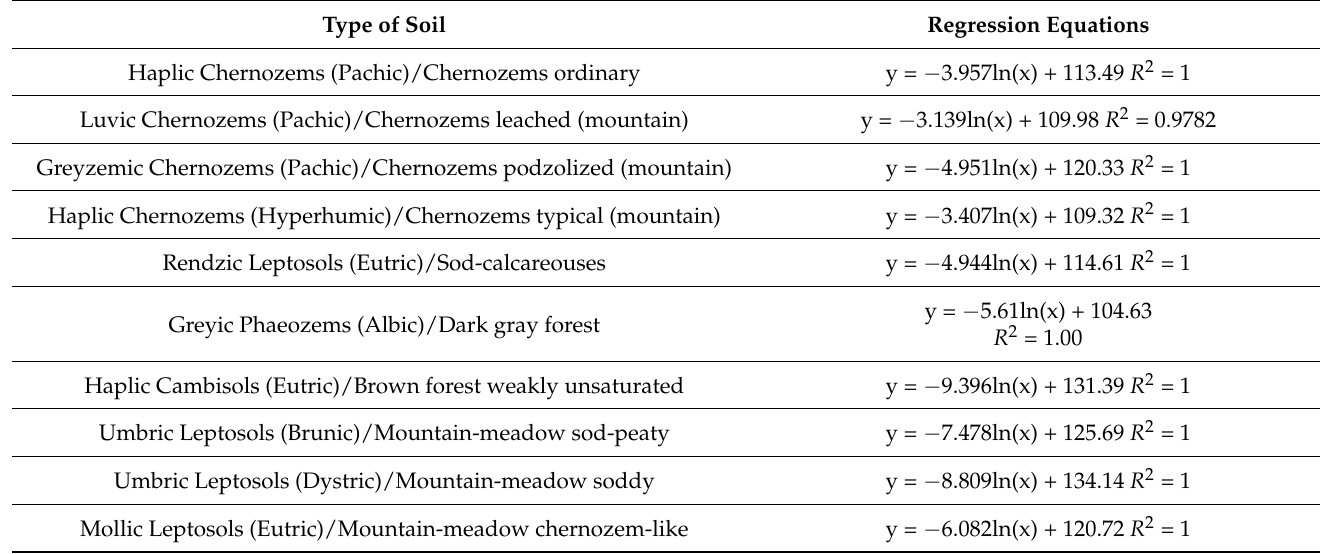
Table 3. Regression equations describing the decrease in IIBS values from the content of Pb in the soil. Type of Soil Regression